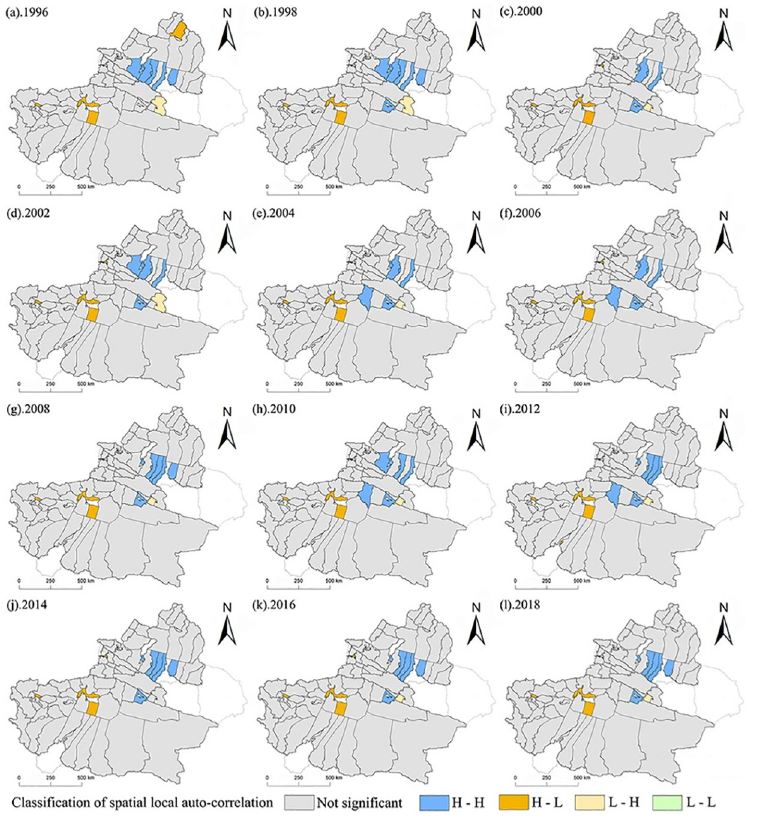
Fig 7. LISA map of coupling coordination in Xinjiang counties from 1996 to